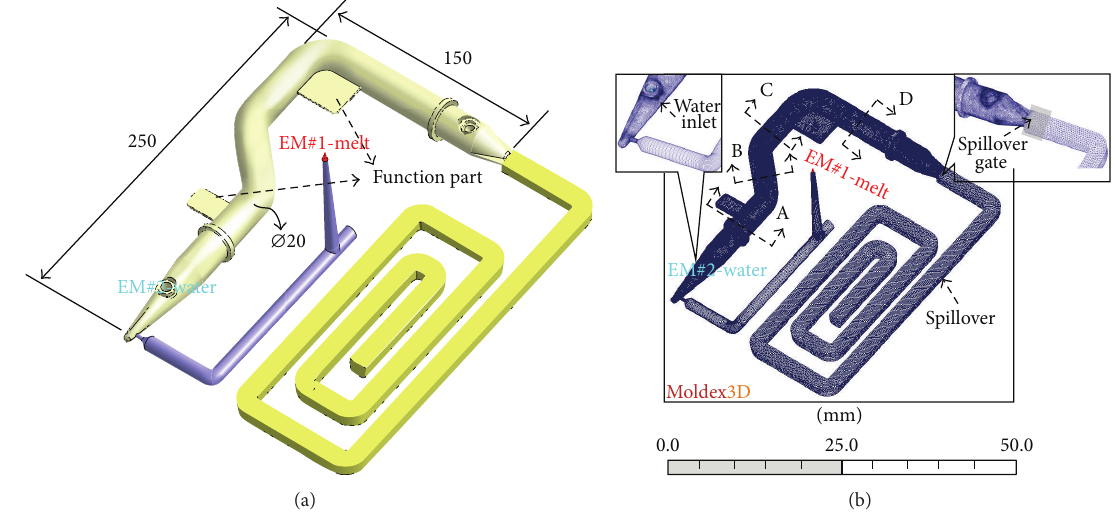
Figure 1: Images of (a) the 3D model and (b) the finite element model for WAIM simulation analysis.